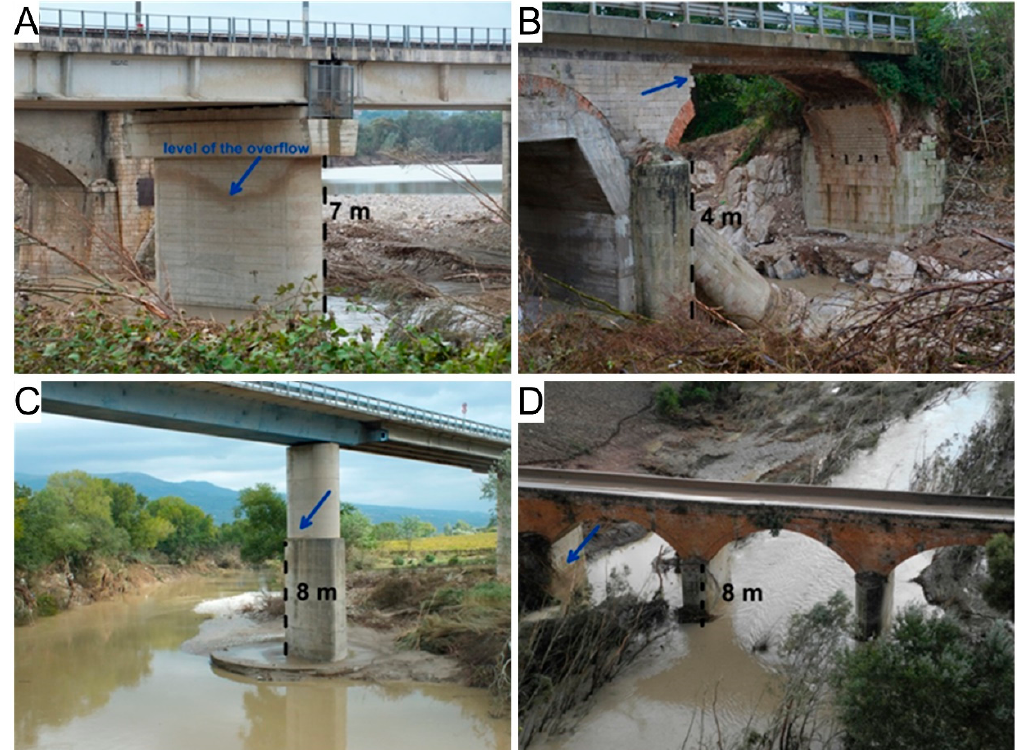
Figure 10. River stage during the overflow of the Tammaro and Calore rivers and Tammarecchia torrent, evidenced by flood marks on bridges, in different places across the Benevento province: ( A ) The Tammaro river in the industrial area (ASI) of Benevento; ( B ) the Tammarecchia torrent in Circello;